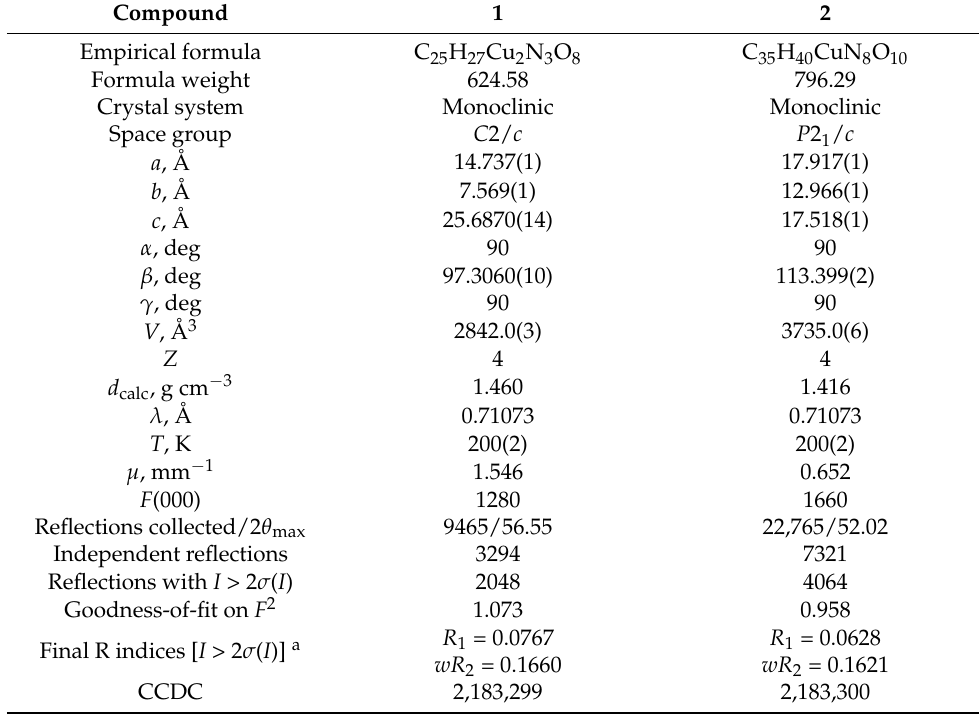
Table 1. Summary of the crystallographic data for polymers 1 and 2